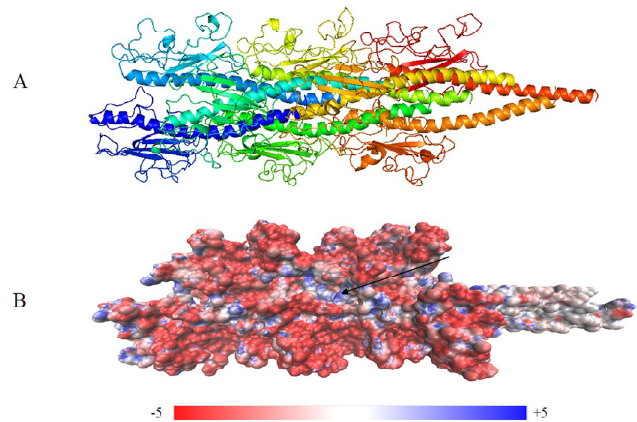
Figure 4. Optimized structure of the G. uraniireducens pilus: ( A ) filament structure containing eight monomers, each indicated by a different color; and ( B ) electrostatic potential distribution on the surface of the optimized structure. Red and blue represent negative and positive potential values, respectively. A deep groove is a possible extended DNA binding site (arrow).